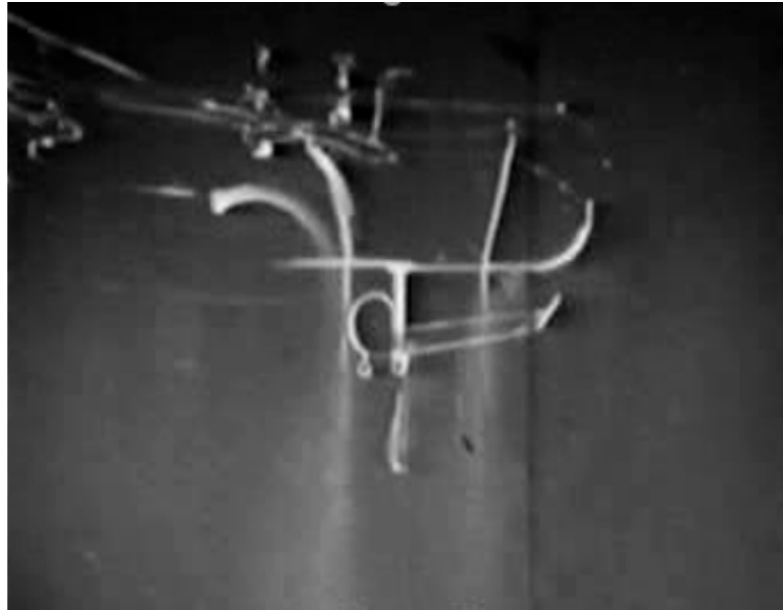
Figure 4. Disturbance diagram of dry-ice airflow around the UAV flight while hovering.